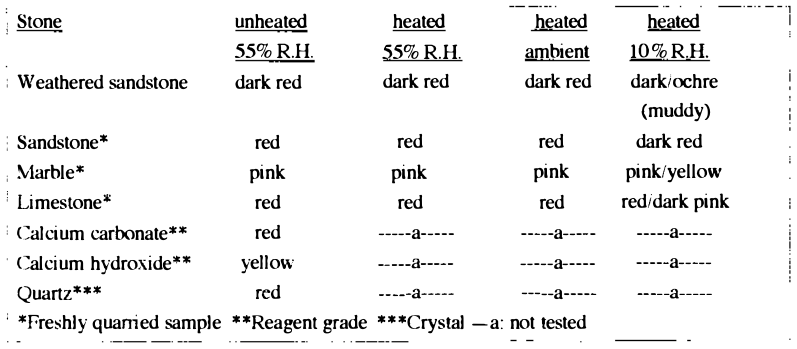
Table 3. Methyl red adsorption and colour change on powdered